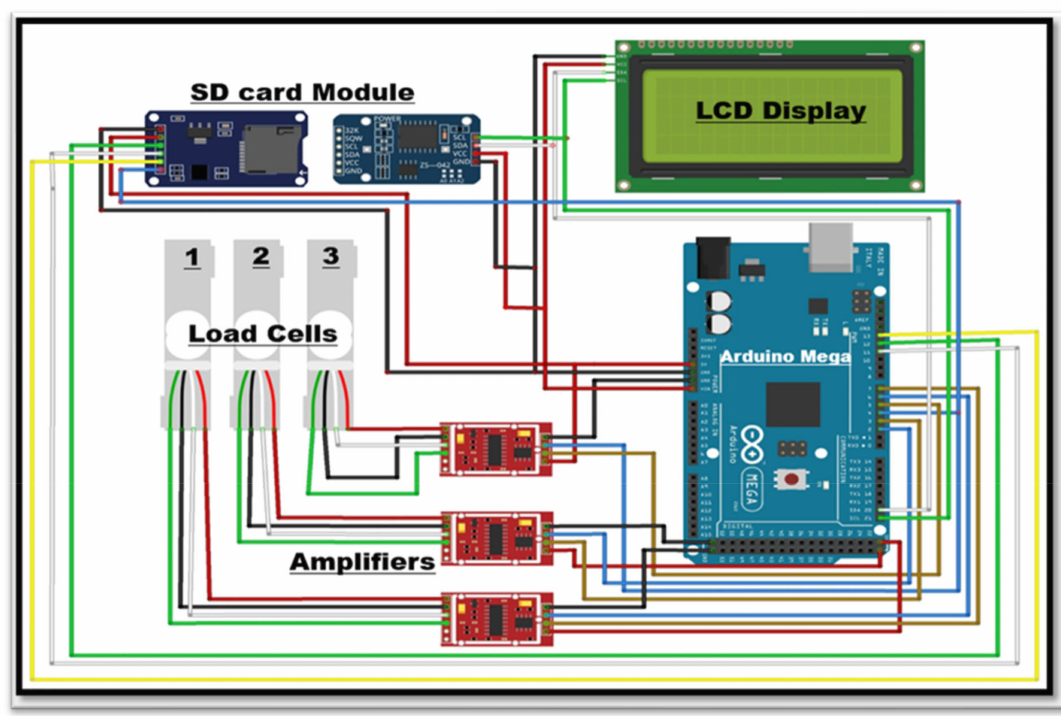
Figure 5. Circuit diagram of different components of the